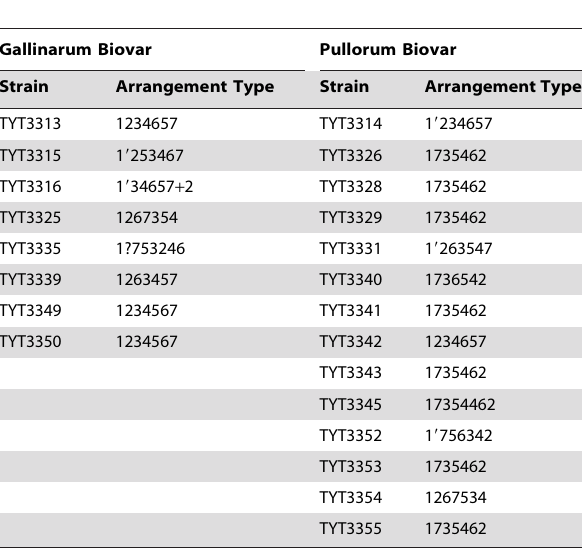
Table 1. Chromosomal arrangement types of Salmonella enterica sv. Gallinarum strains.